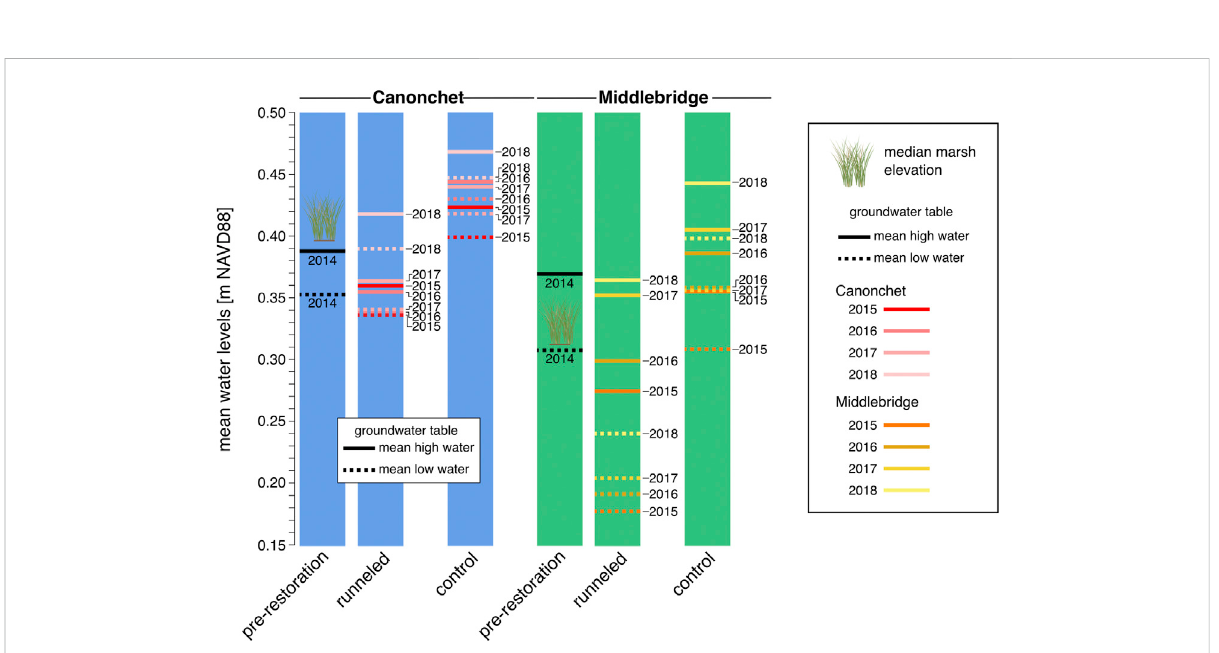
FIGURE 6 Waterlevels atCanonchet andMiddlebridge.Mean marsh elevation isdenoted onthe fi gureusing agrass icon. Overall, water levels werelower inrunneledareas;atMiddlebridgetidalrangewasalsogreaterinrunneledareas.Mean,standarddeviation,andnumberofobservationscanbefound in Supplementary Table